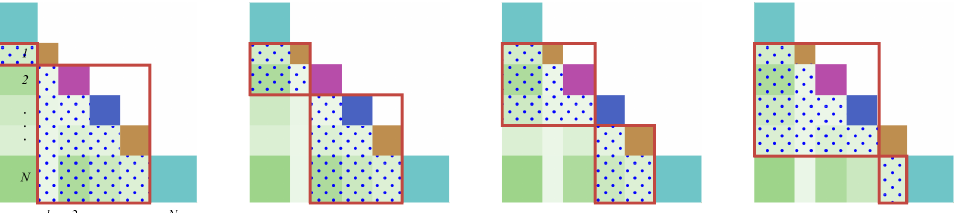
Figure 7. Examples of conceptual similarities used in the Plane method. Each red square represents a topic segment. The light green squares with blue dots inside the red squares indicate the conceptual similarities used in the Plane